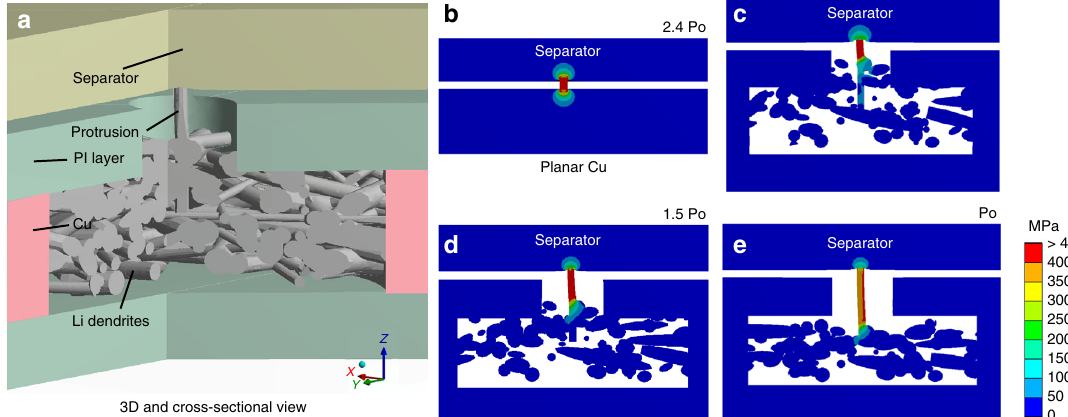
Fig. 3 Simulation of the von Mises stress distribution of the dendritic protrusions at different deposition heights. A vertical protrusion is grown from the lower deposition to the separator in all cases. This protrusion is located at the center of the XY plane. a Three-dimensional and cross-sectional view of the E-Cu@Li model. b Distribution of the protrusion stress in the control case with two-plate electrodes. c – e Distribution of the protrusion stress in the E-Cu- based case with the dendrite layer reaching c 95%, d 75% and e 50% of the height of the compartment. In the top right-hand corners of Fig. 3b – e, the relative area-average von Mises stress from the protrusion towards the separator is